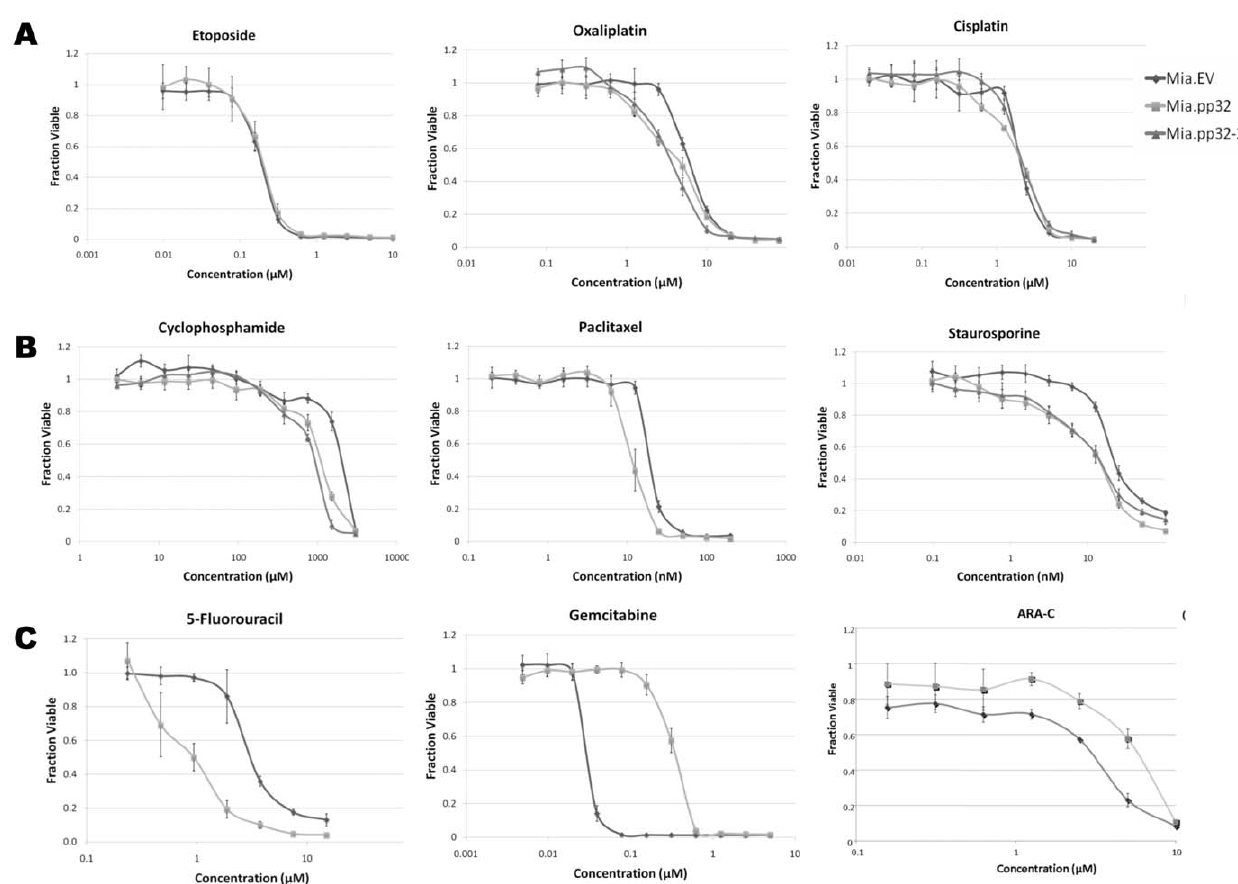
Figure 2. Cell survival assays of Mia.pp32 and Mia.EV cells treated with various chemotherapeutics (Table 1). Survival of Mia.pp32 and Mia.EV lines was measured by the PicoGreen assay after 5–7 days of incubation with the indicated drug doses. (A) Drugs that cause no pp32- dependent sensitivity; (B), drugs showing modest differences in sensitivity; (C) drugs for which pp32 conferred enhanced resistance. Graphs represent single experiments (S.E.M.); each experiment is representative of . three individual experiments. Mia.pp32 lines are indicated as m & and the empty vector control cells are indicated as ¤ .